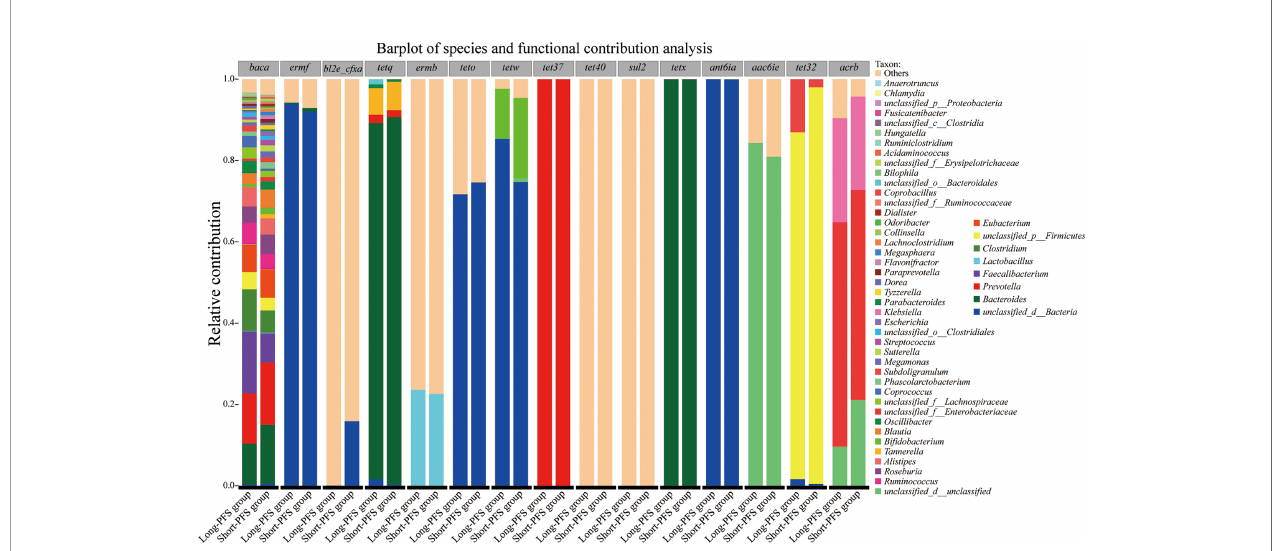
FIGURE 5 | Barplot of species and functional contribution analysis demonstrating the top 50 genus contributing to the top 15 antibiotic resistance gene